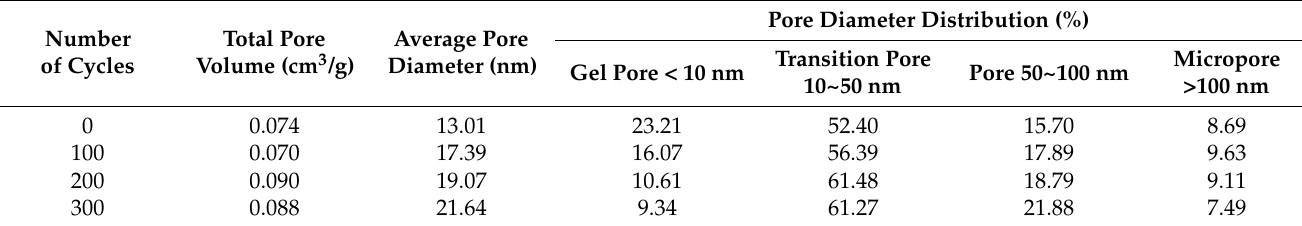
Table 4. Influence of freeze–thaw cycles on the pore structure of hardened paste.